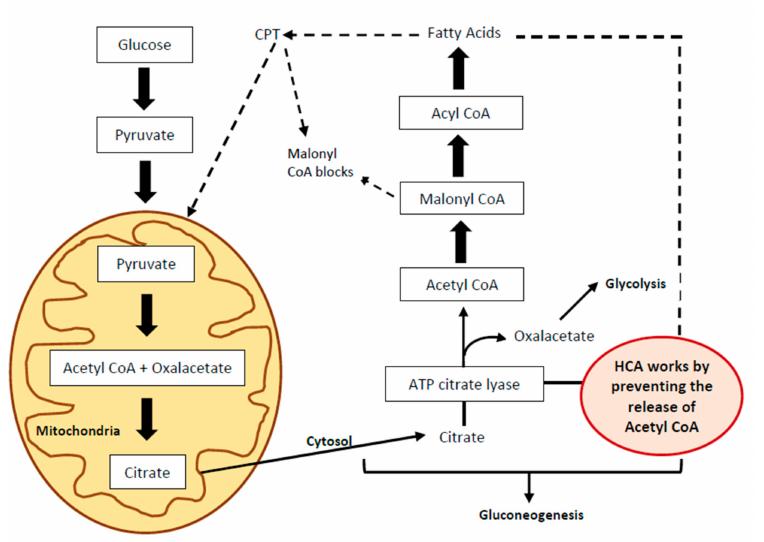
Figure 3. Mechanisms of action of hydroxycitric acid (HCA). CPT: Carnitine